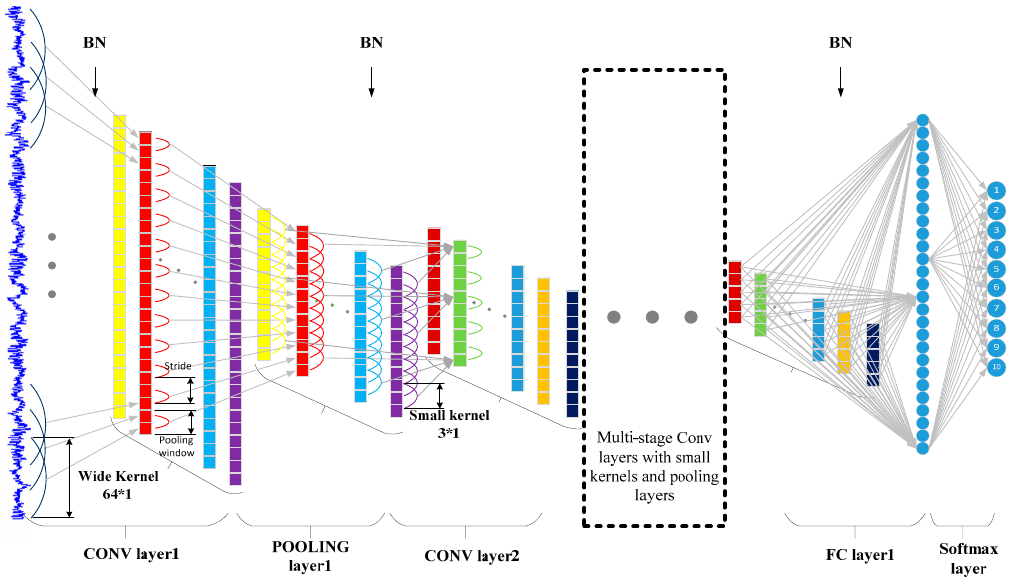
Figure 3. Architecture of the proposed WDCNN model.